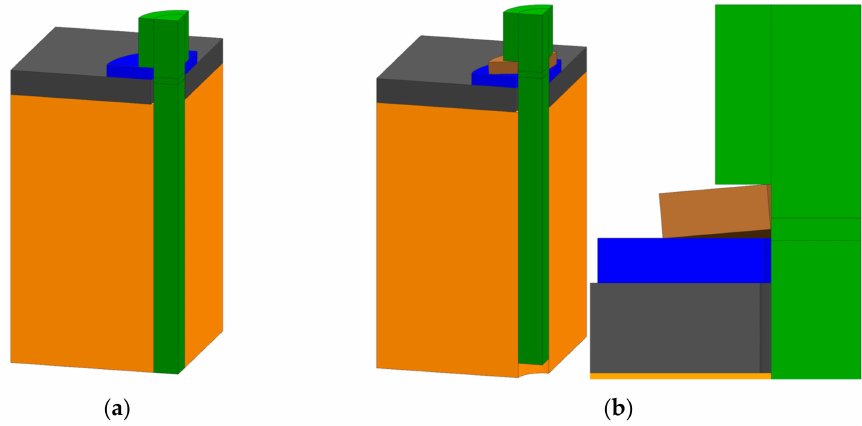
Figure 9. Application-oriented screw assemblies. ( a ) without conical spring washer. (assembly view); ( b ) with conical spring washer (assembly and detail view).